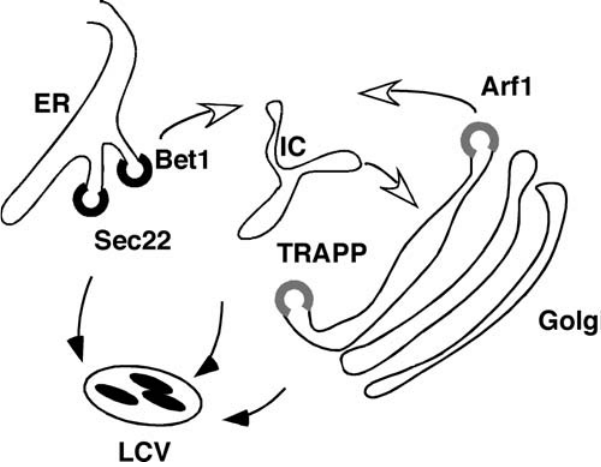
Figure 7. Model for Functional Redundancy The LCV captures secretory vesicles from multiple pathways. Sec22, TRAPP, and Arf1 promote vesicle movement through the IC, and the LCV captures membrane moving from the ER through the IC (white arrows). Alternatively, Sec22 and TRAPP may dock and tether vesicles on the LCV (filled arrows). In either case, Legionella replication is decreased when both pathways are disrupted. DOI: